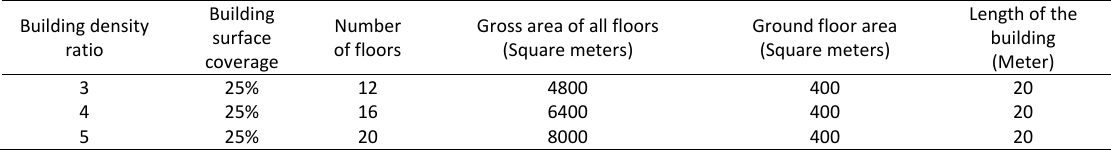
Table 5: Proposed classes for optimizing energy consumption for discrete castings in Khorramshahr Building density